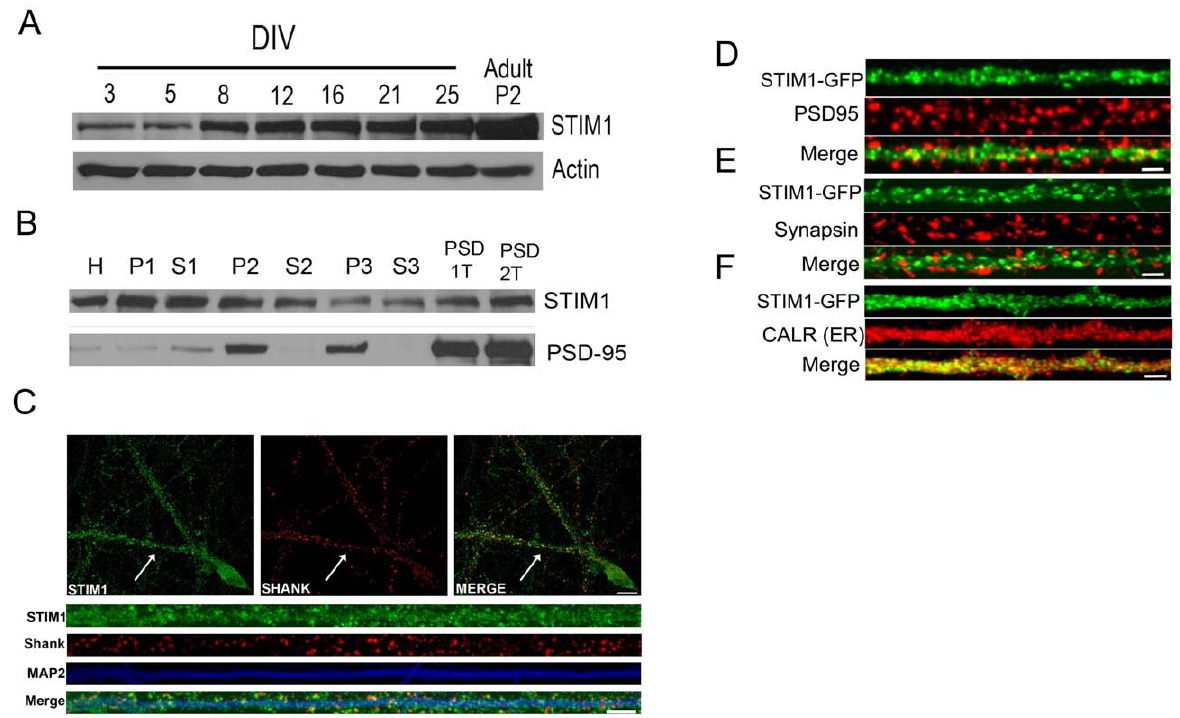
Figure 1. Characterization of STIM1 protein in neurons. (A) Lysates from cultured rat cortical neurons between days in vitro (DIV) 3 and DIV 25 were subjected to western blot analysis with a -STIM1 antibodies. Representative blots depicted from 3 independent experiments. (B) Western blot of adult rat brain fractions isolated by differential and density gradient fractionation probed with a -STIM1 antibodies (top panel) and a -PSD-95 (middle panel). Fractions are as follows: rat brain homogenate ( H ), crude synaptosome( P2 ), crude synaptosome supernatant ( S2 ), lysed synaptosomal membrane fraction ( P3 ), crude synaptic vesicle fraction ( S3 ), single Triton X-100 extracted PSD ( PSD-1T ), and a double triton X-100 extracted PSD ( PSD- 2T ). Representative blots depicted from 2 independent experiments. (C) Immunostaining of endogenous STIM1 protein in cultured rat hippocampal neurons (DIV 21). Neurons were immunolabeled with a -STIM1 (green), a -Shank (red), and a -MAP2 (blue) antibodies. Whole scale bars, 20 m m; dendrite scale bar, 10 m m. Cultured rat hippocampal neurons (DIV 21 and 4; A thru D and E thru F, respectively) were infected with Sindbis STIM1-GFP virion. Expression was allowed to continue for 12 hours prior to fixation, permeabilization, and immunolabeling with a - PSD-95 (D), a -synapsin (E), a - calreticulin (F) antibodies. Representative images depicted from . 30 images acquired per co-stain. Scale bar =5 m m.